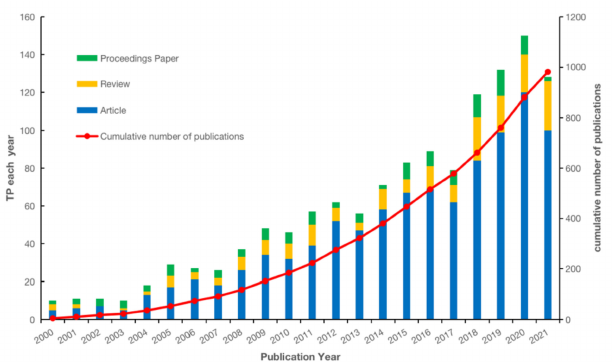
Figure 2. The scientific outputs from